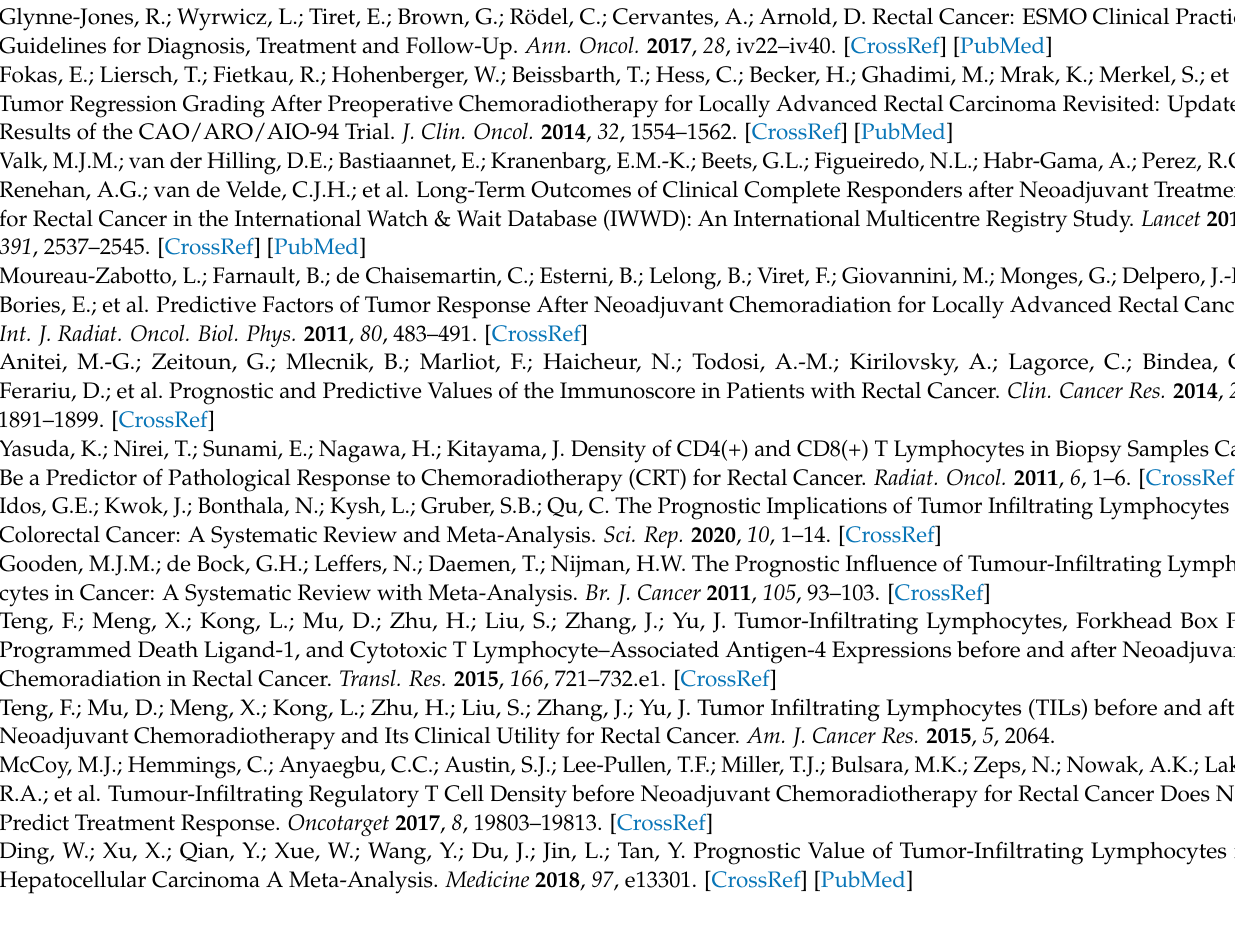
strategy, Table S3: Newcastle-Ottawa Scale, Table S4: GRADE assessment of the quality of evidence for pCR and pTR, Table S5: GRADE assessment of the quality of evidence for DFS and OS, Figure S1: CD3 + TILs density and pTR, Figure S2: CD4 + TILs density and pTR, Figure S3: FOXP3 + TILs density and pTR, Figure S4: Prognostic value of FOXP3 +